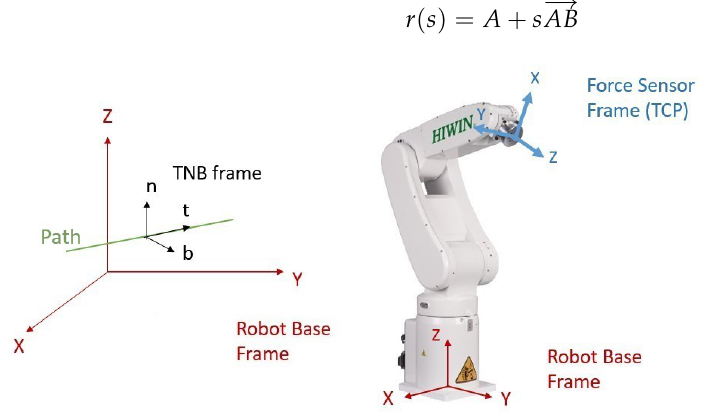
Figure 5. Coordinate frames description. Force sensor frame in blue, robot base frame in red, tangential-normal-binormal (TNB) frame in black, and predefined path in